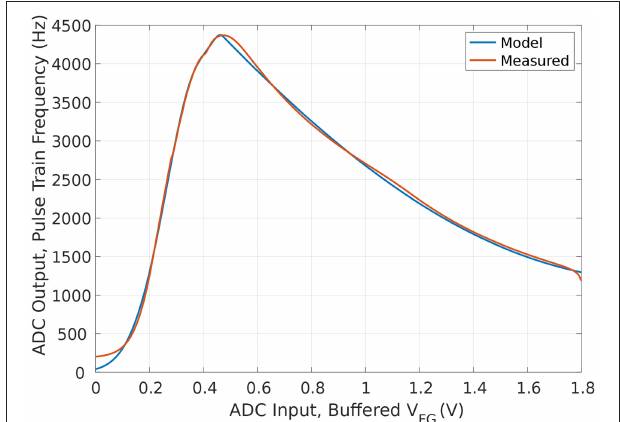
FIGURE 4 | Input-output characteristic of the pulse encoder ADC, peak output frequency occurs near 470mV. Though not monotonic in frequency output, the duty cycle of the pulses is different on either side of the peak output frequency.